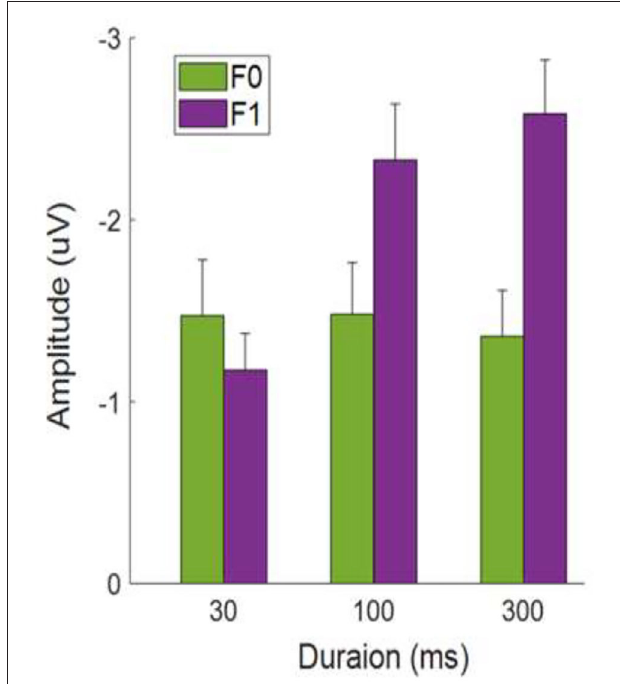
FIGURE 4 | Average MMN mean amplitudes as a function of tone sweep duration. Note that up and down sweeps are combined. Error bars indicate ± 1 standard